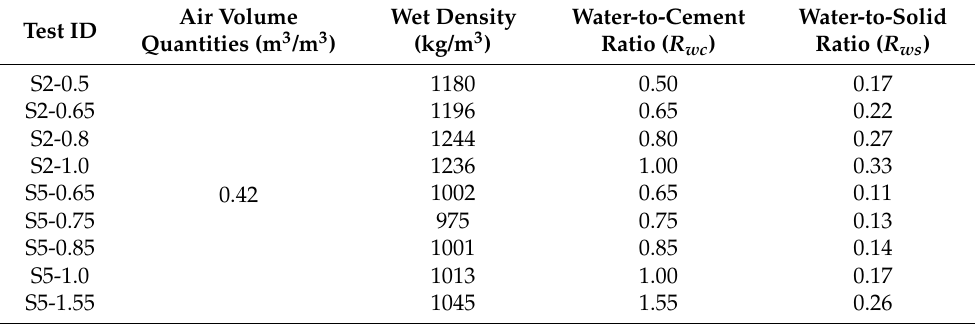
Table 1. Composition of foam concrete mixtures.